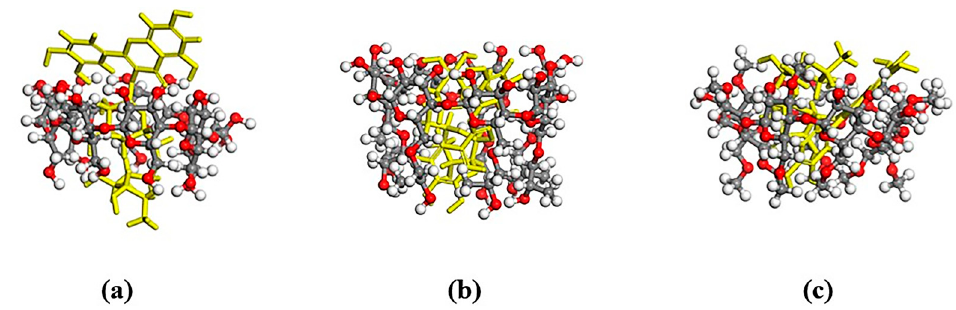
Figure 9. The most-stable conformations of ( a ) rutin/ β -CD; ( b ) rutin/HP- β -CD and ( c ) rutin/DM- β - CD. (The yellow molecule represents rutin. The white, red and gray spheres represent the H, O and C atoms in cyclodextins, respectively.)